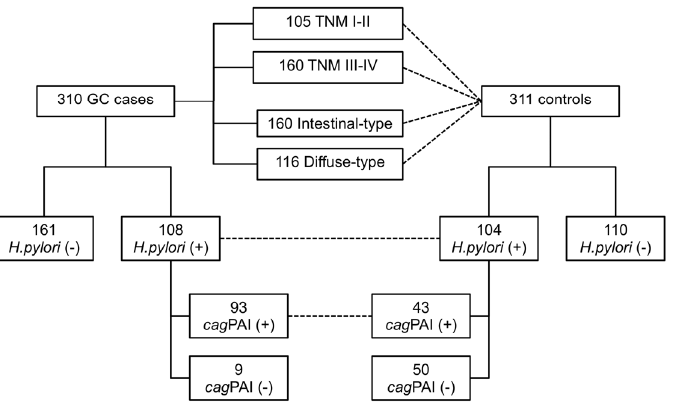
Figure 1. Flowchart of the comparisons among subsets. Dashed lines represent the stratified analysis.